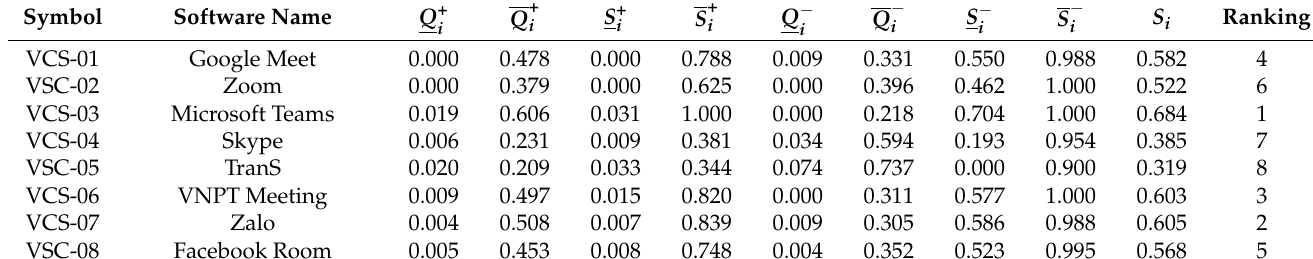
Table 9. The appraisal score S i of G-EDAS.